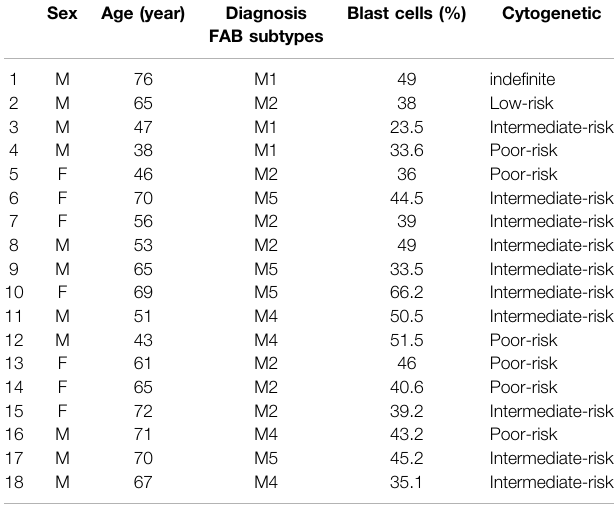
TABLE 1 | The clinical characteristics of AML patients in our